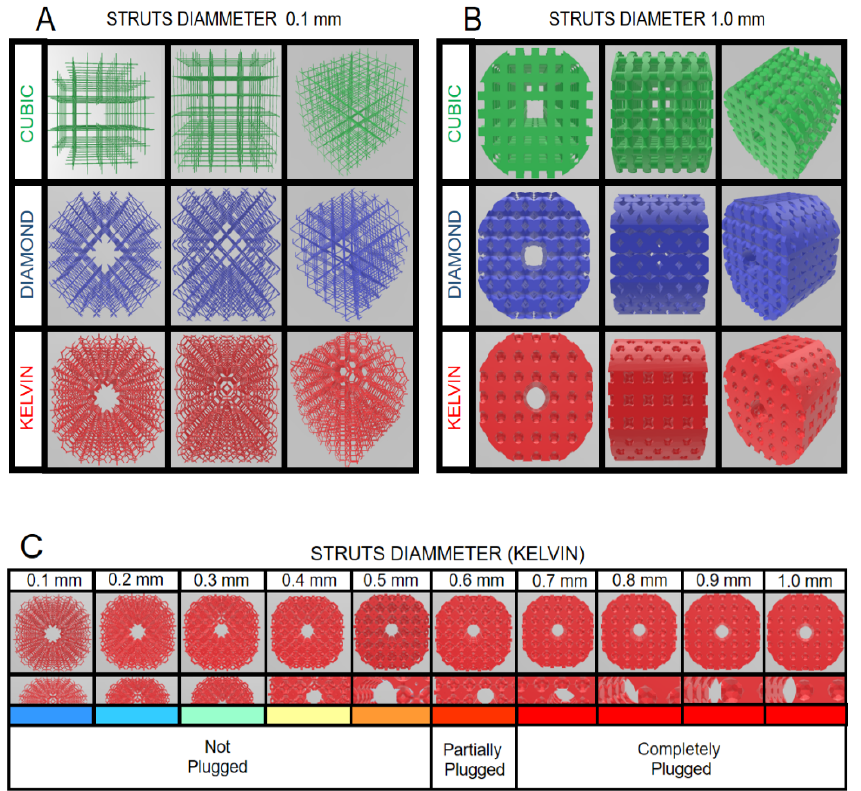
Figure 1. ( A ) Views of the POCS made with struts of 0.1 mm; ( B ) Views of the POCS made with struts of 1.0 mm; ( C ) Views of the progressive plugging of the POCS with Kelvin unit cell as the strut diameter increases.